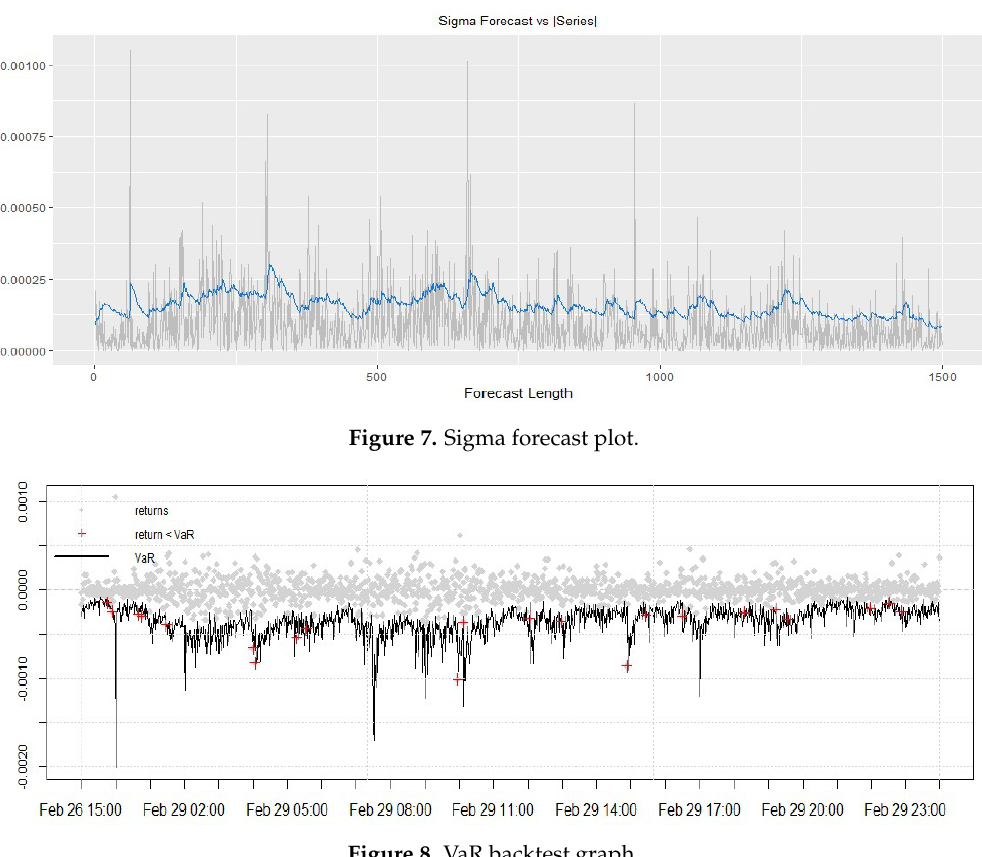
Figure 8. VaR backtest graph.